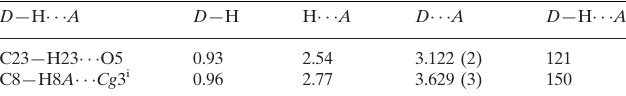
Hydrogen-bond geometry (A˚ , (cid:3)